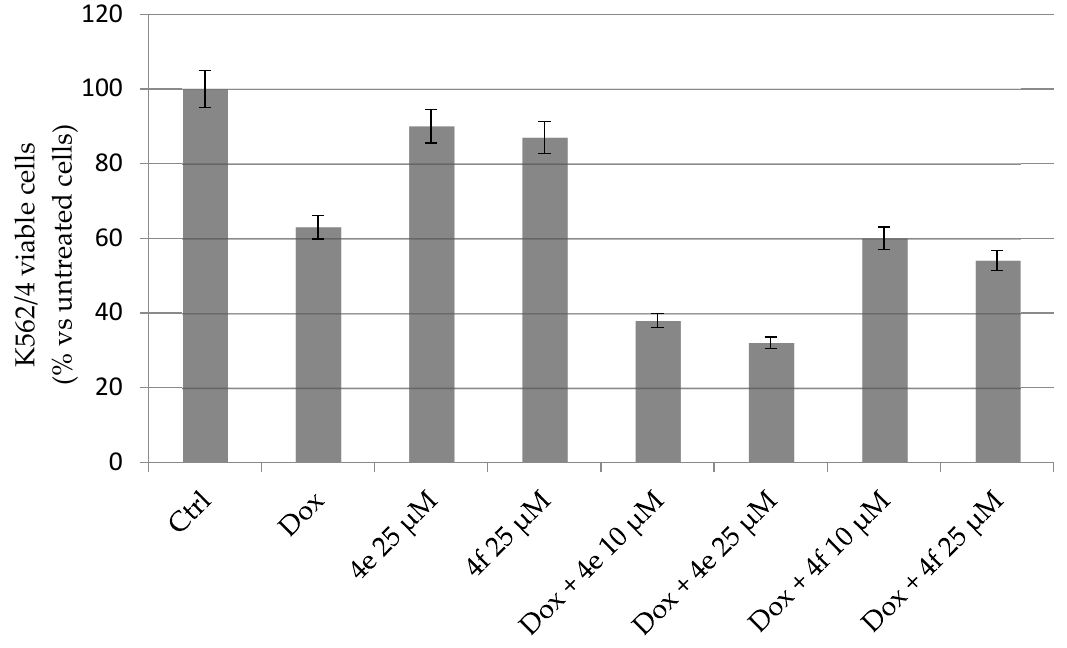
Figure 6. Susceptibility of resistant K562/4 line to combinations of Dox (25 µM) with indoline-5- sulfonamides 4e and 4f . Data are presented as means ± SD ( n = 3).